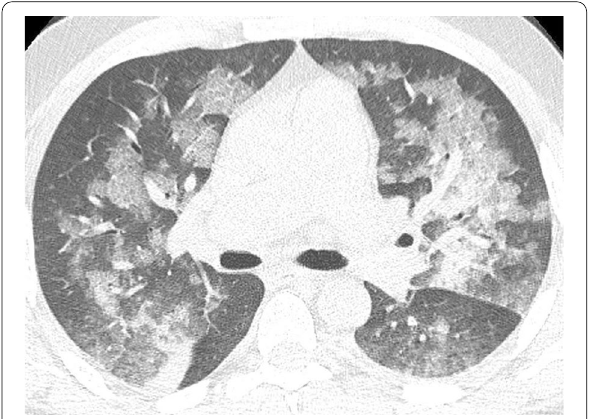
Fig. 12 Non‑infectious mimickers of indeterminate COVID‑19. Pulmonary alveolar proteinosis proved by bronchoalveolar lavage (BAL) in a 38‑year‑old male smoker, axial CT image shows asymmetric bilateral patchy areas of GGO superimposed with interlobular septal thickening and crazy paving pattern, right‑side fissural effusion is also